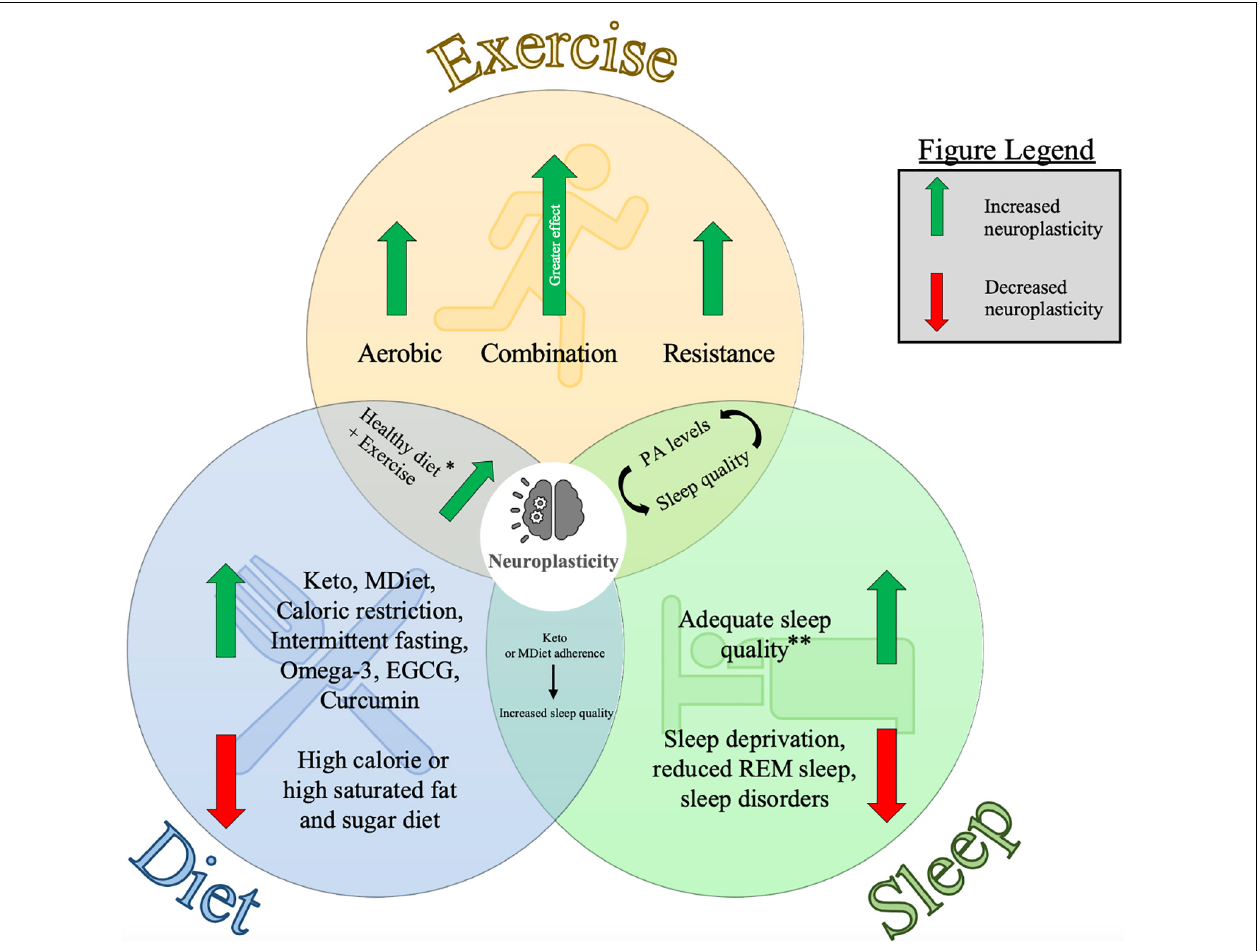
FIGURE 1 | Diagram representing the individual and combined influences of exercise, diet and sleep on neuroplasticity. This figure summarizes the key points from each of the major sections of this article and visually depicts how they are interrelated. Findings from this review are from studies in human and animal models. Neuroplasticity was measured using several techniques including neurophysiological measures, molecular biomarkers, and cognitive assessments (see Tables 1 , 2 for further information). Keto: Ketogenic diet, MDiet: Mediterranean diet, EGCG: (–)epigallocatechin-3-gallate, REM sleep: rapid-eye movement sleep, PA levels = physical activity levels. ∗ Healthy diet here refers to evidence from the Ketogenic diet, Mediterranean diet and nutritional supplements. ∗∗ Adequate sleep quality is specific to individuals depending on age and other health factors. See Ohayon et al. (2017) for further information related to sleep